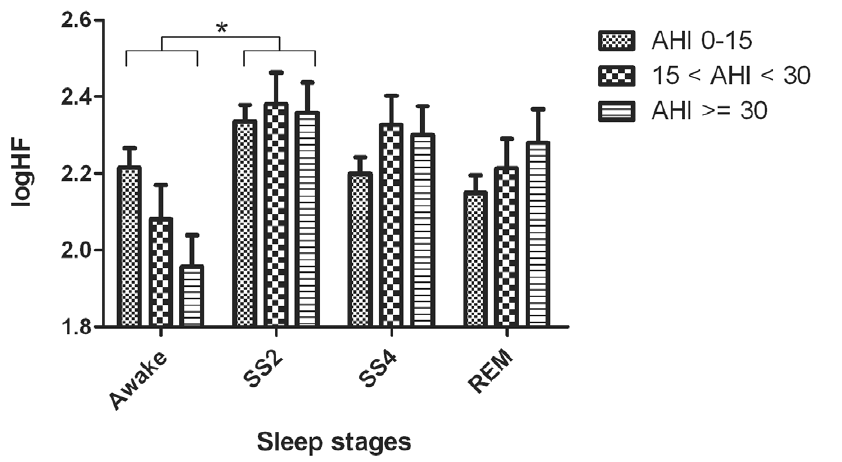
Figure 6. Group and sleep related comparisons of log transformed high frequency power (logHF) (mean ± SD). (* represents p , 0.05).